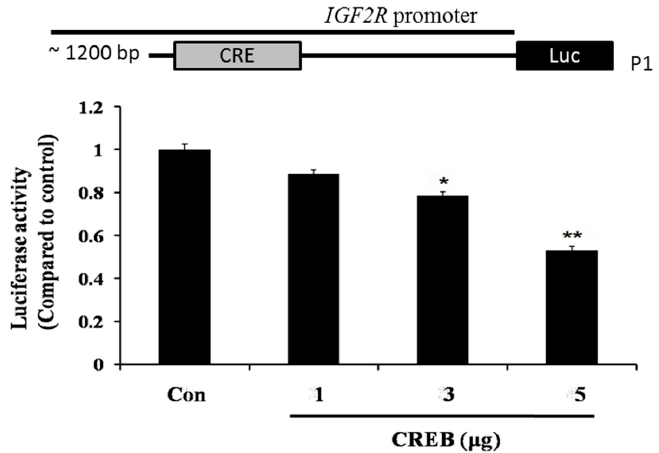
Figure 4. CREB suppressed IGF2R gene expression by directly targeting the promoter region of IGF2R. Schematic diagrams of the IGF2R gene indicating predicted EBPRE sites. H9c2 cells were transiently co-transfected with empty or CREB over-expression vectors and with luciferase-reporter constructs (P1) containing ~1.2 kb of the IGF2R promoter, either containing or not containing the predicted EBPRE site. Luciferase activity is compared with the control. * p < 0.05, ** p < 0.001 represent significance when compared to control.